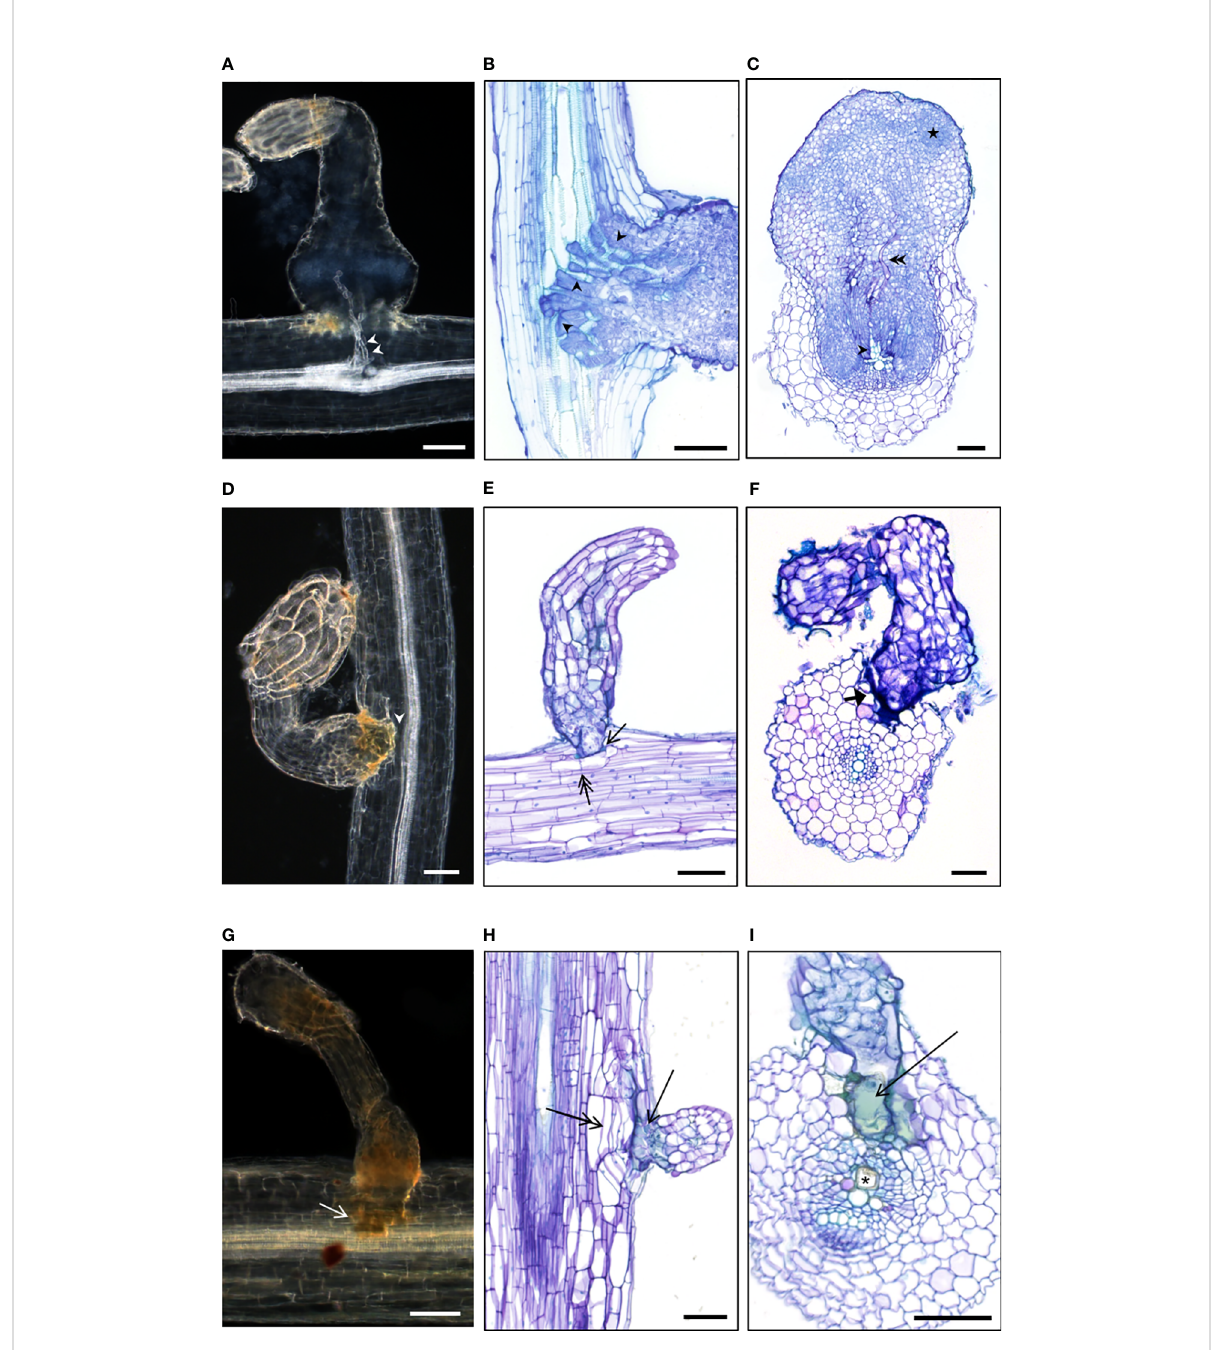
FIGURE 5 Cytological study of compatible and incompatible attachments revealed various cellular resistant mechanisms (A – C) Compatible attachments of susceptible wild H . annuus or cultivated H . annuus with established vascular connections. Xylem vessels indicated by white arrowheads in (A) and black arrowheads in (B) Phloem vessels indicated by double black arrowheads in (C) The star indicates Orobanche dividing cells preparing bud development. (D – I) Incompatible attachments of resistant wild Helianthus species. ( E, F ) no or few cortical cell divisions (double arrow in E ); phenolic compounds at the basis of the haustorium (arrow in E ); thick cell wall surrounding the haustorium (thick arrow in F ). (H, I) cortical cell division under or around the haustorium (double arrow in H ), phenolic compounds (arrow in H, I ), mucilage deposition in the host xylem vessel (asterisk in I ). The pictures were taken from various accessions: (A) H. annuus # 649; (B) sun fl ower control XRQ; (C) sun fl ower control 2603; (D) H. annuus # 833; (E) H. exilis # 2601; (F) H. bolanderi # 584; (G) H. annuus # 833; (H) H. grosseserratus # 290; (I) H. annuus # 833. (A, D, G) Whole cleared root samples with attachments. (B, C, E, F, H, I) Sections of included root samples with attachments, stained with toluidine blue O. Bars = 100